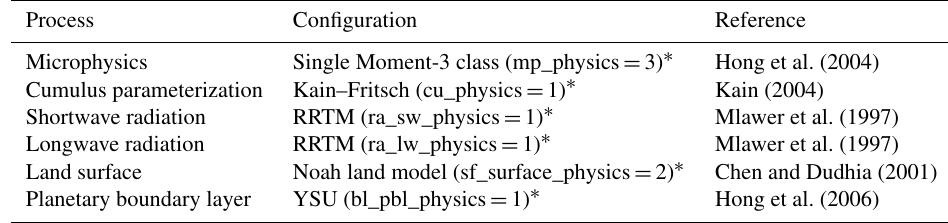
Table 1. WRF 3.6 physical configurations used in the model